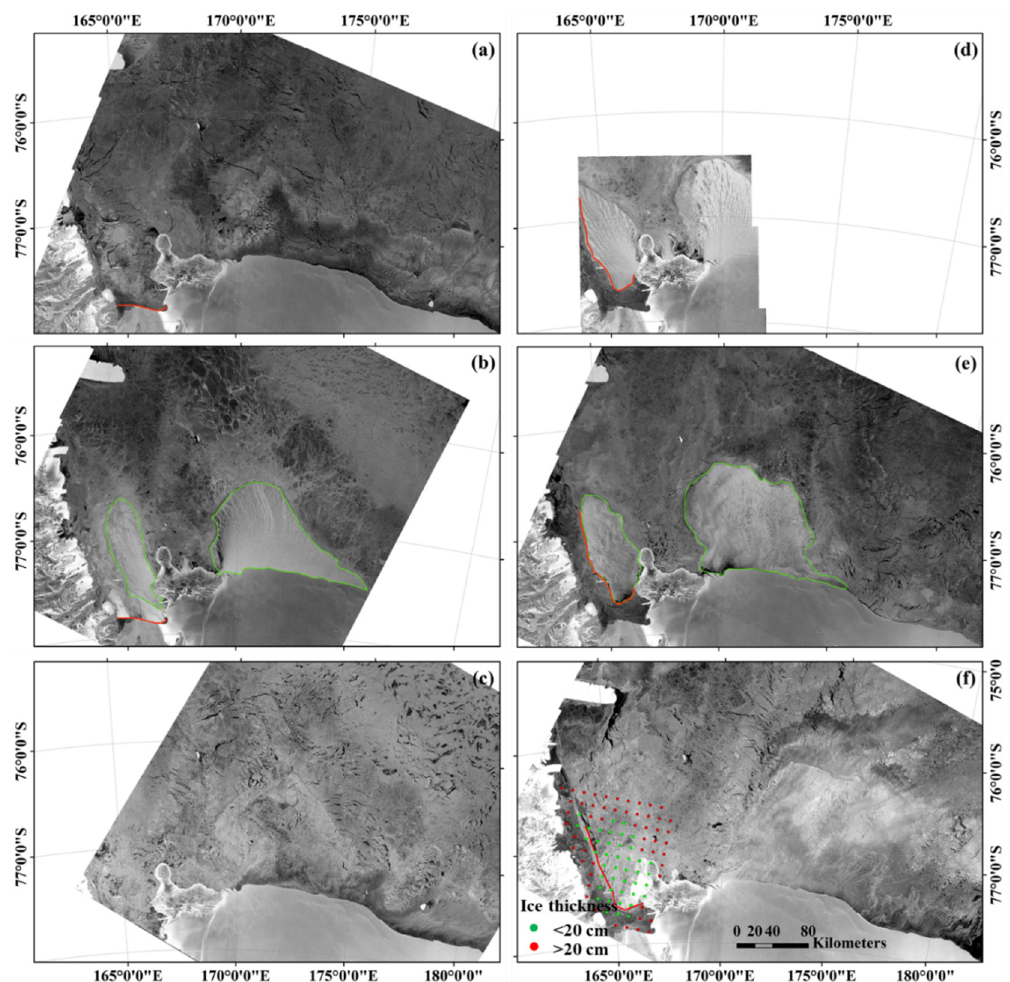
Figure 2. Examples of Sentinel-1 SAR images on 3 April 2017 ( a ) (no polynya), 5 April 2017 ( b ) (clear polynya), and 7 April 2017 ( c ) (disappearance of polynya); 19 August 2017 ( d ) and 20 August 2017 ( e ) together explain the incomplete scan in ( d ); 28 October 2018 ( f ) indicating the thin ice (green dots) from passive microwave data overlaying the Sentinel-1 SAR image in the McMurdo Sound. The green (red) dots indicate ice thicknesses <20 cm (>20 cm) and the solid red line is the McMurdo fast ice edge.